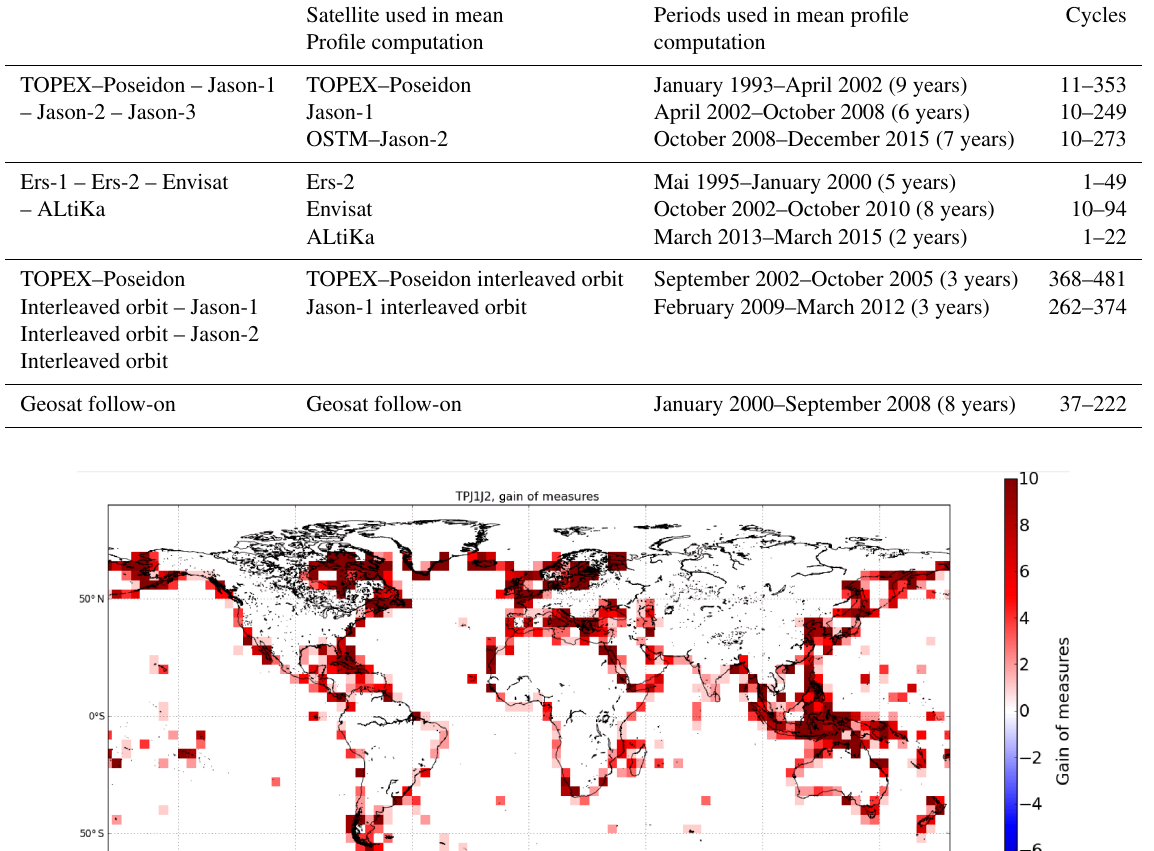
Table 2. Time periods and cycles used to compute the mean profile in the DT2018 version.